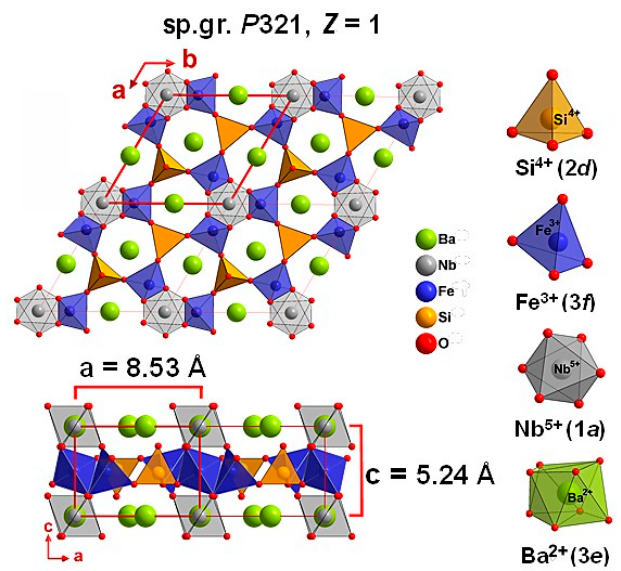
Figure 1. Crystal structure of Ba 3 NbFe 3 Si 2 O 14 at ambient pressure and room temperature. The values of unit cell parameters are indicated.